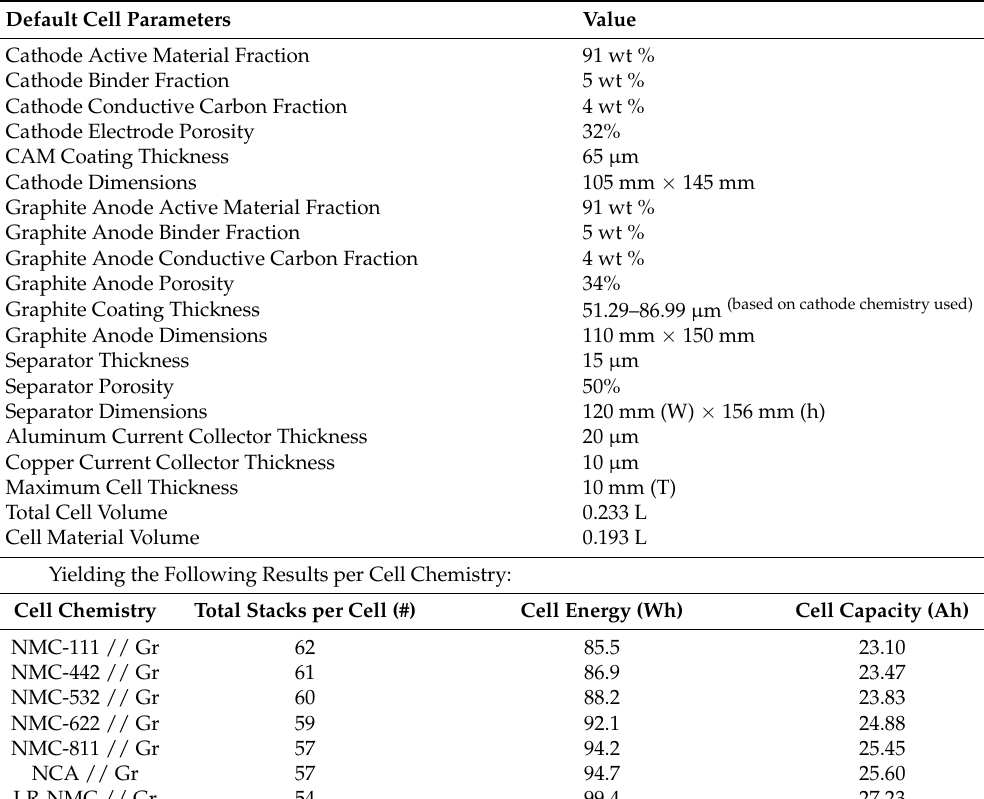
Table 1. Key cell parameters from